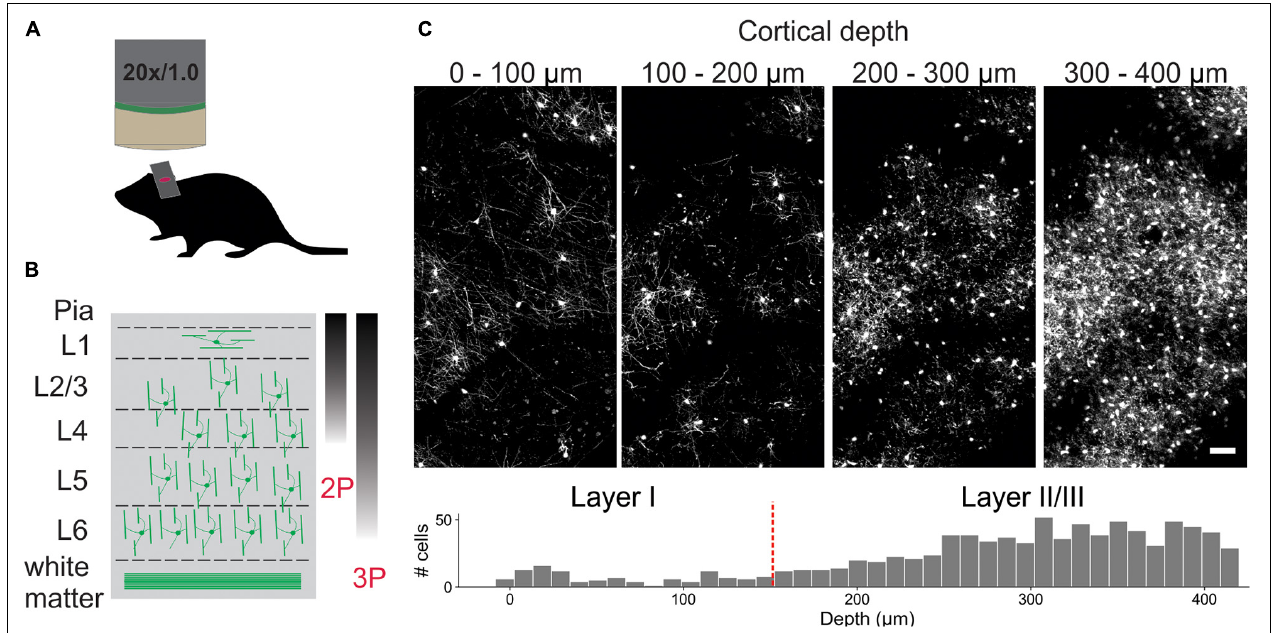
FIGURE 1 | In vivo imaging of oligodendrocytes. (A) Cranial windows were surgically implanted in adult Mobp-EGFP mice in which only oligodendrocytes express EGFP. (B) Orientation of oligodendrocytes from imaging surface to white matter. Oligodendrocytes in upper cortical layers myelinate horizontally aligned axons, while those in deeper cortical layers are aligned perpendicularly to pial surface. Standard imaging range of two-photon and three-photon microscopy highlighted with approximate gradients (Theer and Denk, 2006; Lecoq et al., 2019) (C) XY maximum projections of 100 µ m thick volumes at indicated depths (0–100 µ m, 100–200 µ m, 200–300 µ m, and 300–400 µ m). Layer depths as estimated in somatosensory cortex (Narayanan et al., 2017). Oligodendrocyte density increases rapidly with depth, increasing the time needed for manual tracking. Scale bar: 50 µ